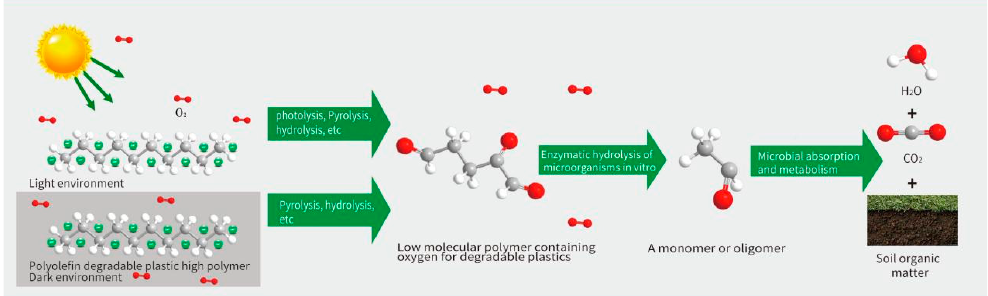
Figure 1. Degradation process of degradable plastic products.